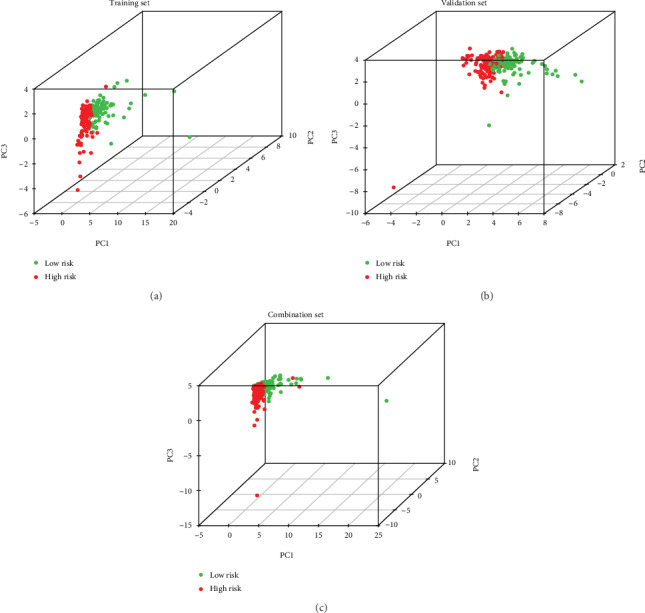
Principal component analysis (PCA) based on the seven immune-related lncRNAs showed that the low-risk group and high-risk group tended to separate into two sides. (a) Training set. (b) Validation set. (c) Combination set.